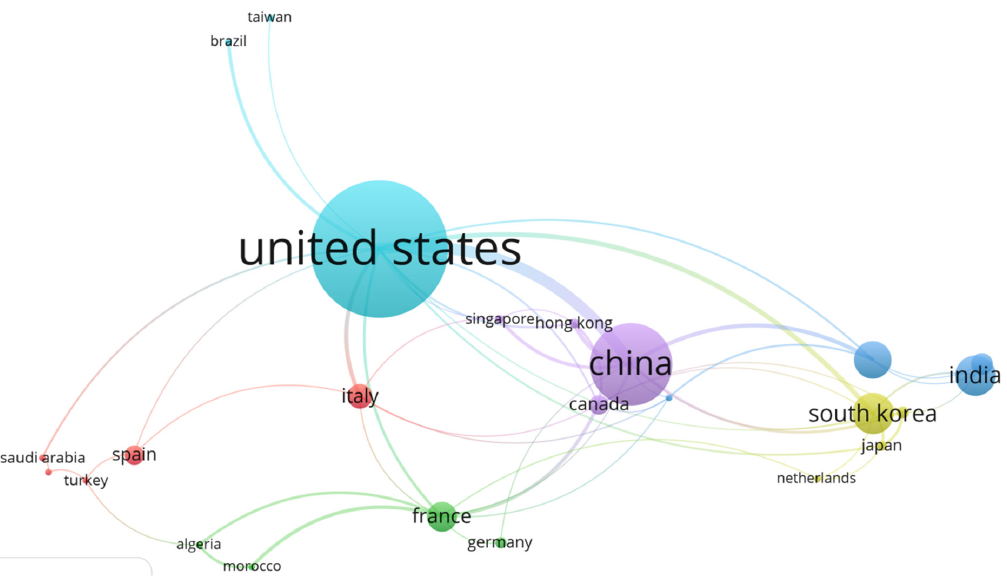
Figure 6. The country’s networks in the research of PMEH with low-cost applications.